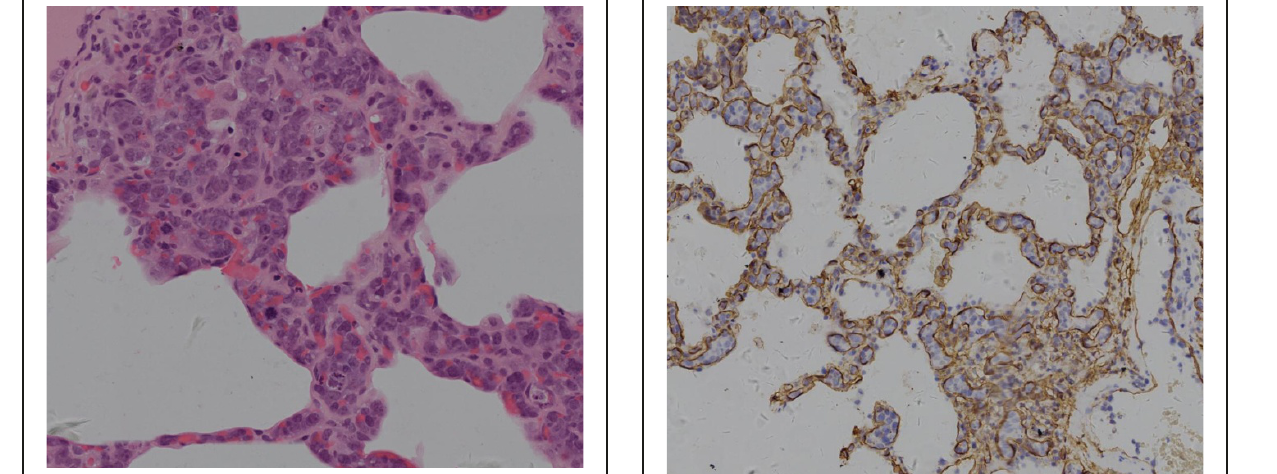
Figure 3 Hematoxylin-eosin staining of pulmonary interstitium intravascular lymphoma (400X),the the alveolar septae was widen and filled with tumour cells showed in high power field.